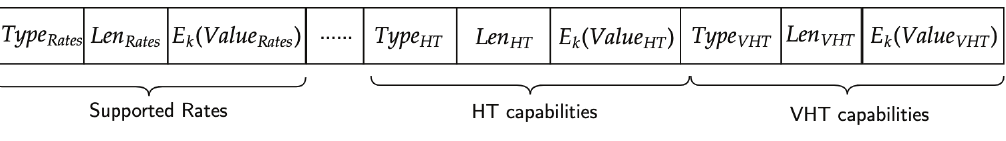
Figure 6. Structure of encrypted frame